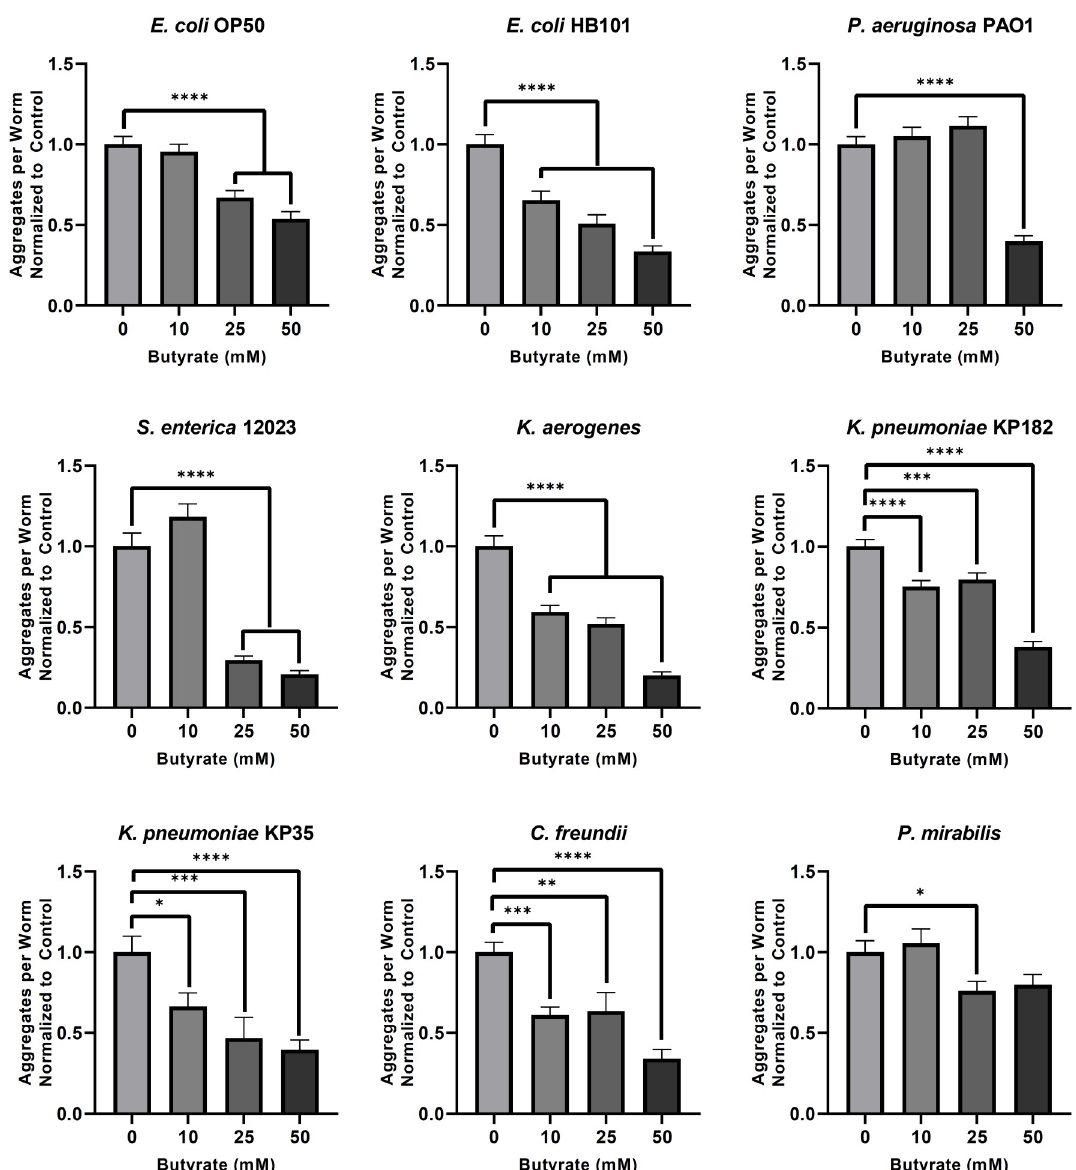
Fig 6. Butyrate affects bacteria-mediated protein aggregation in the C . elegans muscle. Data are represented as the average number of aggregates of muscle-specific polyQ35 (AM140) per worm normalized to the control (0 mM butyrate). Each bar is an average of three independent experiments with a total of 100 animals and the error bars represent SEM. Statistical significance was calculated using one-way ANOVA followed by multiple comparison Dunnett’s post-hoc test ( � p < 0.05, �� p < 0.01, ��� p < 0.001, ���� p < 0.0001).